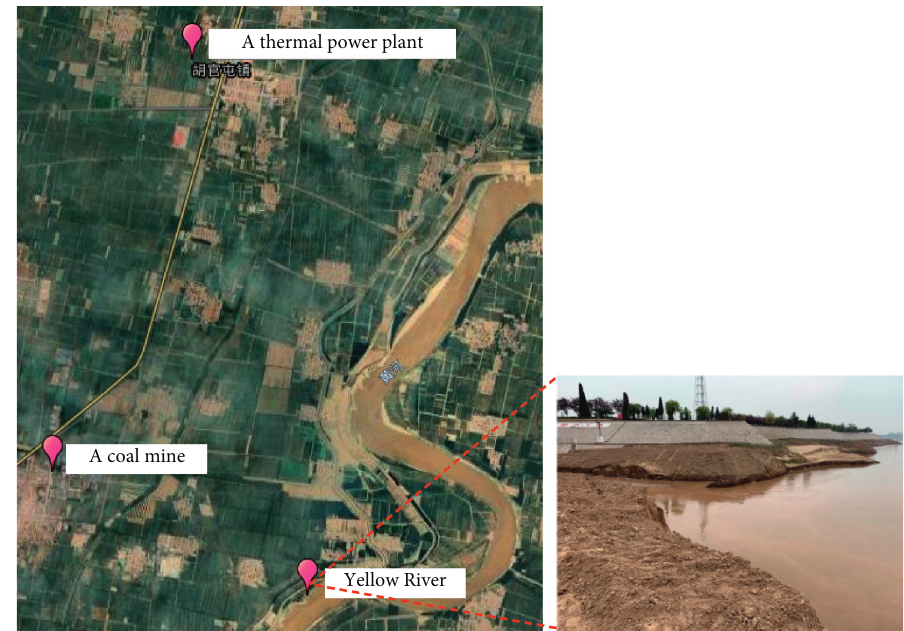
Figure 1: The location of study site.